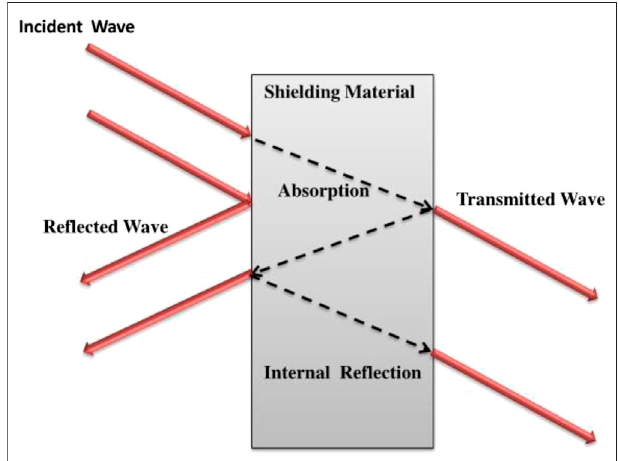
FIGURE 1 | Keyword occurrences from 2001 to 2020 in Scopus documents.